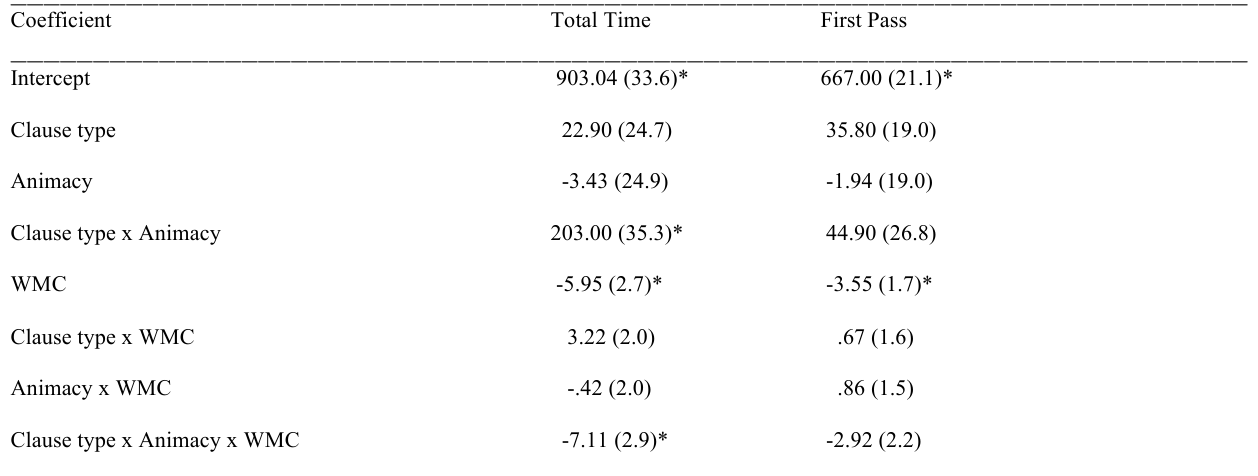
Hierarchical Linear Model – Model Estimates from Traxler, Williams, Blozis, & Morris (2005) Experiment